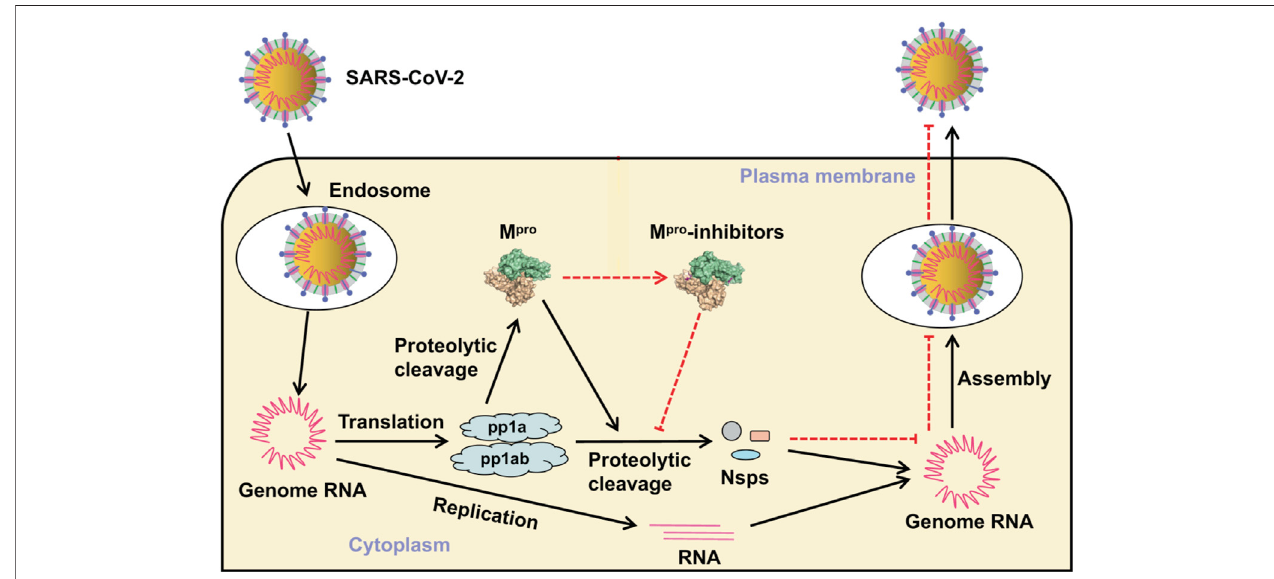
FIGURE 1 | Virus entry and replicative cycle. M pro produces non-structural proteins (Nsps) that are essential for assembly of the viral replication transcription complex needed for RNA synthesis. Inhibitors bind to M pro , resulting in failure of virion assembly and inhibited release of new virions. Adapted from Mengist et al. (2020)